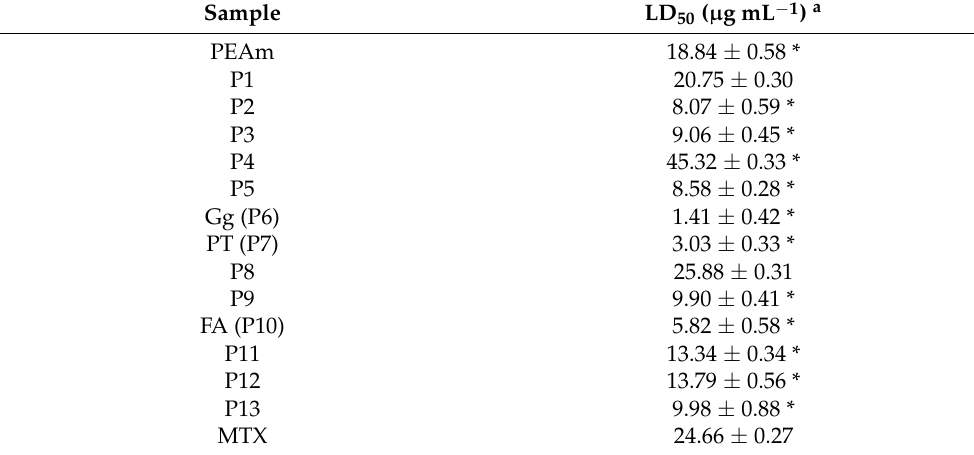
Table 1. LD 50 of the thirteen compounds isolated (P1-P13) by preparative thin-layer chromatography from petroleum ether extract of A. macroprophyllata leaves and methotrexate (MTX) obtained from the BSL